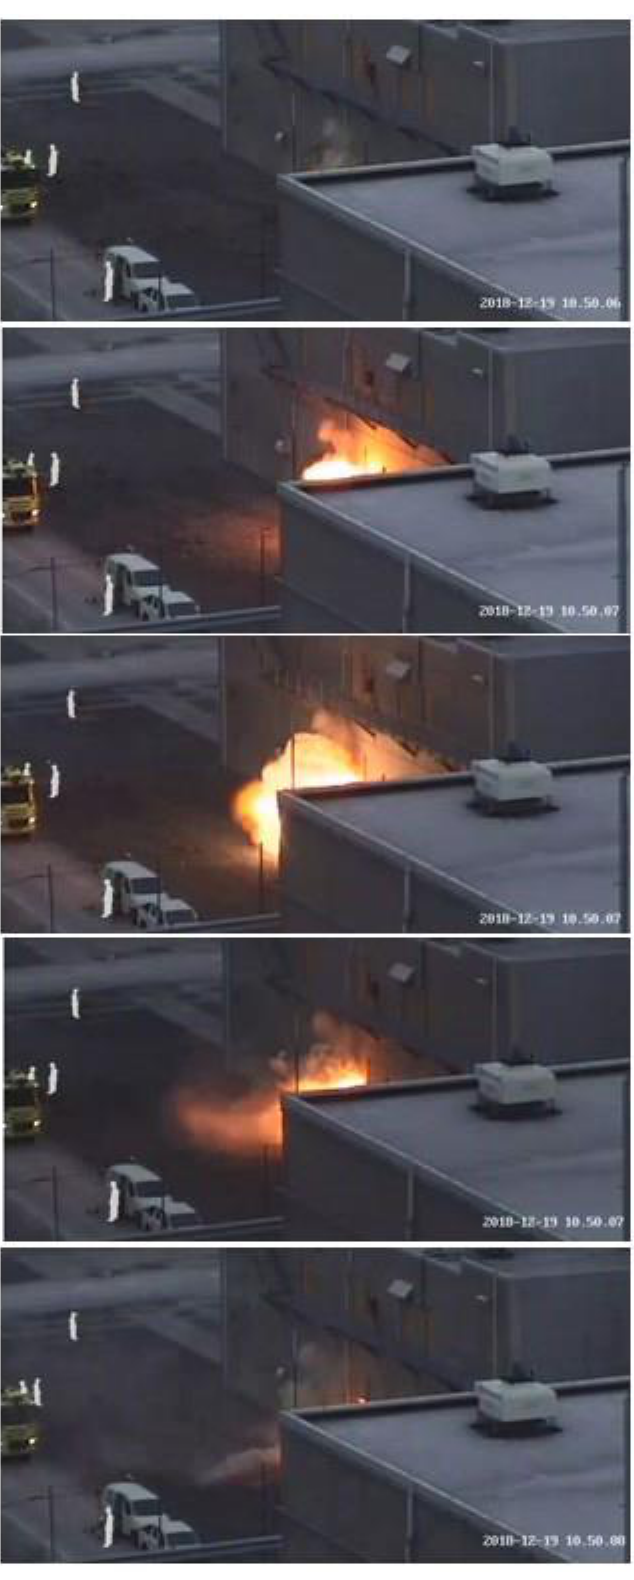
Figure 6. A two-second sequence of photos showing the explosion at 10:50:06–10:50:08. The location of personnel in close vicinity to the ignition is shown as white markers [16].